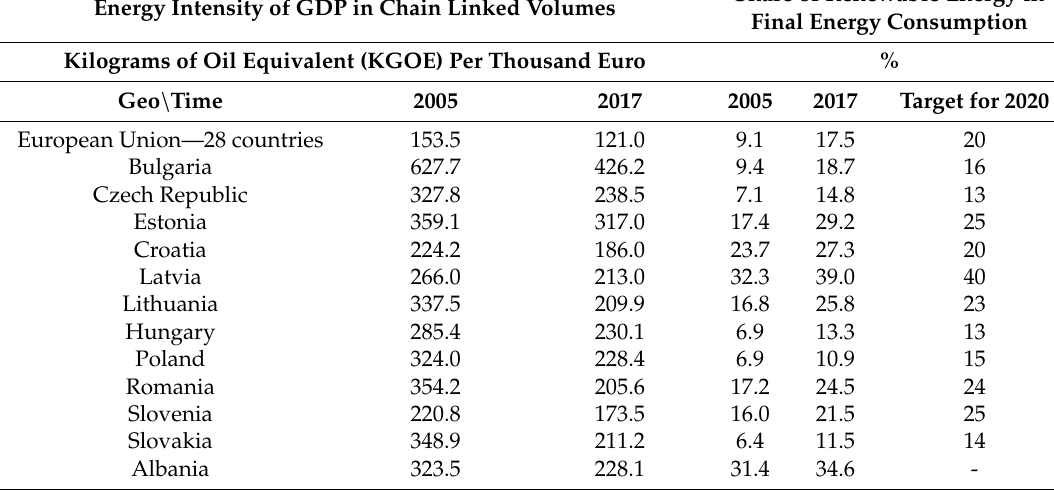
Table 1. The importance of energy for the economy. Energy Intensity of GDP in Chain Linked Volumes